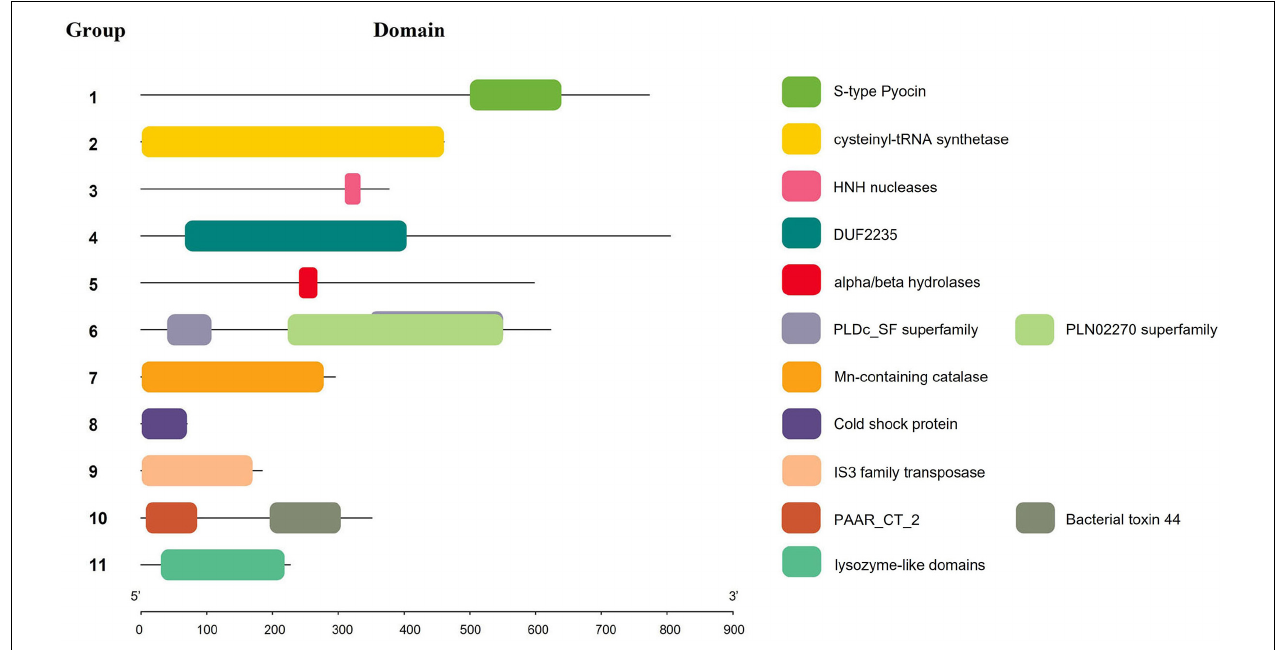
FIGURE 4 | Schematic representation of domains of effectors in K. pneumonia e. Squares of different colors indicate different domains, and numbers represent effector protein groups.